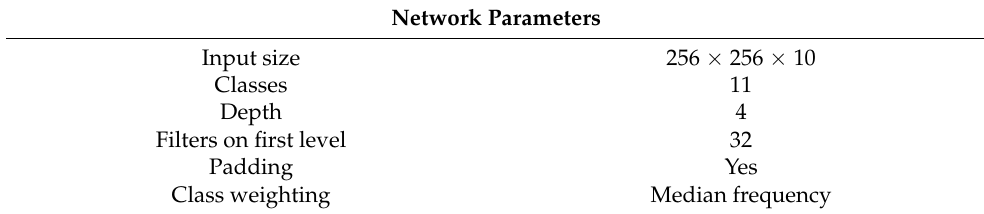
Table 14. Network parameters for UNet on UOS2.